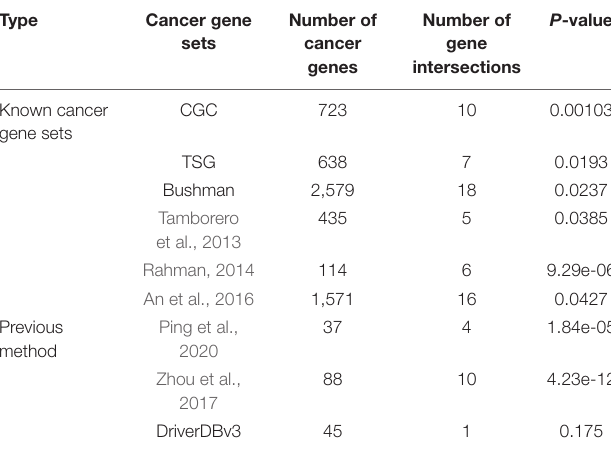
TABLE 1 | The performance of our method compared with six known cancer gene sources and three previous